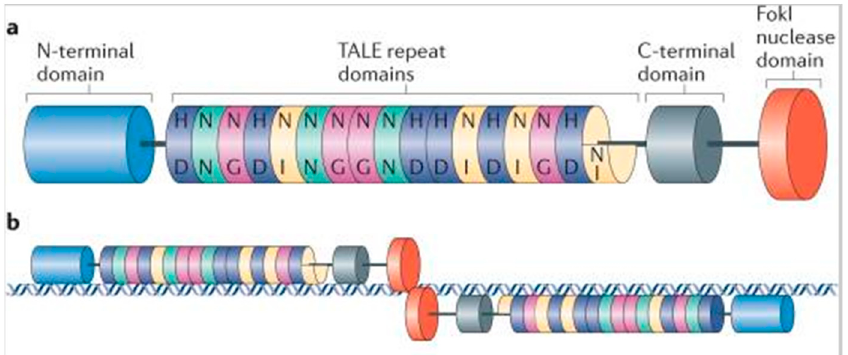
Figure 4. ( a ) Schematic diagram of a TALEN. ( b ) TALENs bind and cleave as dimers on a target DNA site and cause DSBs in the “spacer” sequence [37]. site and cause DSBs in the “spacer” sequence [37].